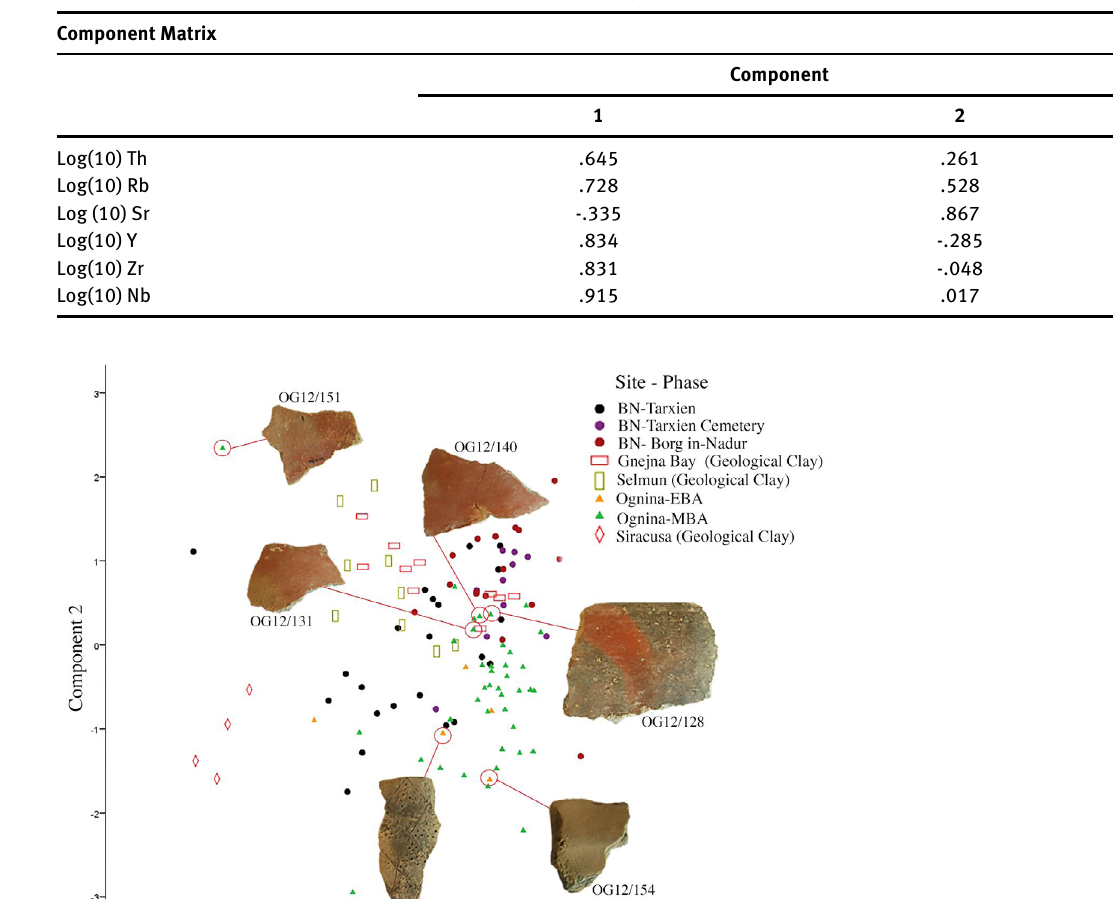
Table 2. PCA Component matrix showing how the trace elements load on each component. Principal component scores were determined from the log transformation of the trace elemental compositional data for each sample listed in Table 1.